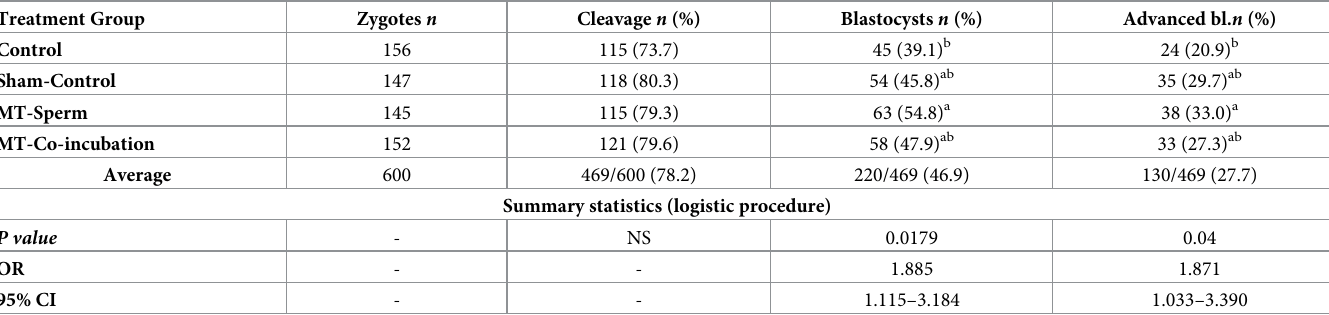
a,b Logistic procedure: Percentages within columns with different superscripts differ ( P < 0.05). Blastocyst rate is considered as the proportion of cleaved zygotes that reached the blastocyst stage. Advanced bl. refers to advanced blastocysts (expanded and hatching) based on the number of cleaved zygotes. OR: Odds ratio. 95% CI: 95% confidence intervals limits for relative risks. Control (n: 156): without any supplements. Sham-Control (n: 147): Ethanol in the sperm preparation medium. MT-Sperm (n: 145): Melatonin in the sperm preparation medium. MT-Co-incubation (n: 152): melatonin in the in vitro fertilization co-incubation medium. Cleavage: NS: no significant ( P > 0.05). Data were collected from six IVF